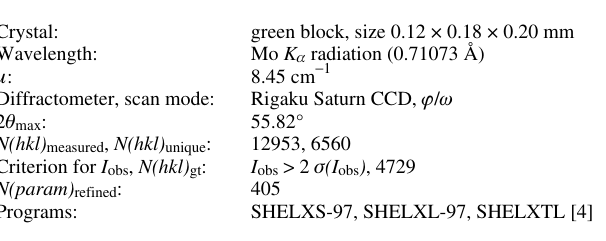
Table 1. Data collection and handling.